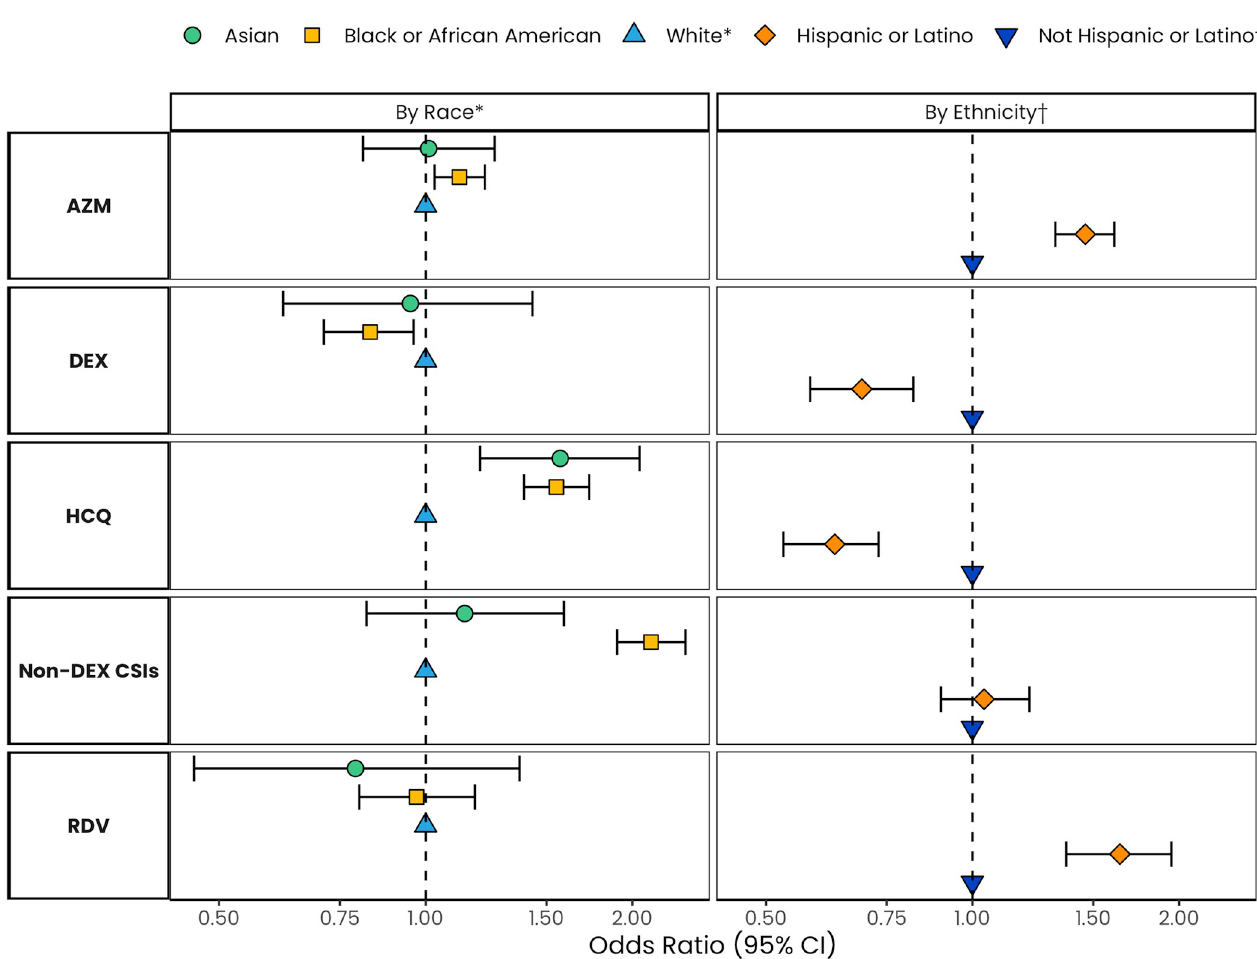
Fig 1. Adjusted odds of receiving COVID-19 treatments at admission by race and by ethnicity. � Regression Models stratified by Race are calculated using White Race as the referent group, and adjust for the following: race, age, sex, frailty, Charlson-Quan score, Medicare insurance, Medicaid insurance, Commercial insurance, COVID-19 severity, region, SNF/NH/ALF, overweight/obesity, smoking, and month of admission. The analytic cohort included 15,745 patients after excluding those with Other/Unknown race. † Regression Models stratified by Ethnicity are calculated using Not Hispanic/Latino Ethnicity as the referent group, and adjust for the following: ethnicity, age, sex, frailty, Charlson-Quan score, Medicare insurance, Medicaid insurance, Commercial insurance, COVID-19 severity, region, SNF/NH/ALF, overweight/obesity, smoking, and month of admission. The analytic cohort included 16,915 patients after excluding those with missing